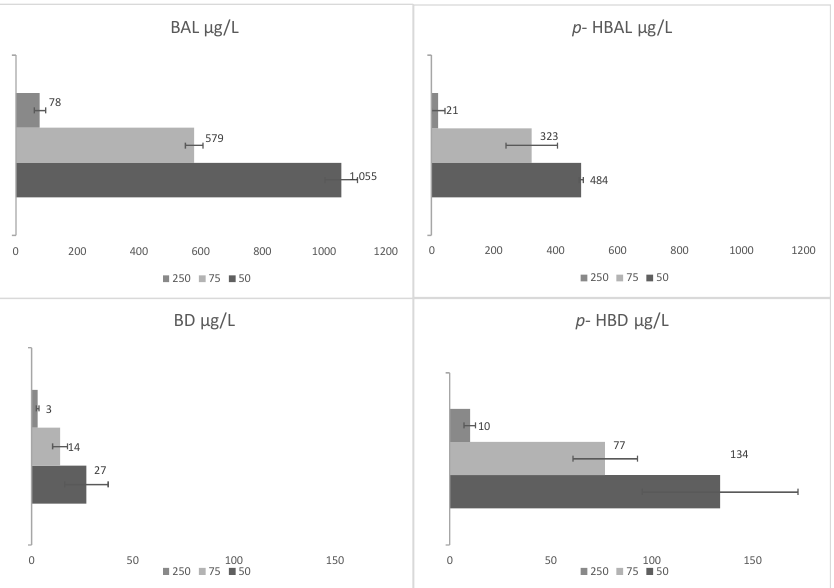
Figure 5. Formation of benzyl alcohol (BAL), benzaldehyde (BD), p -hydroxybenzyl alcohol ( p -HBAL), and p -hydroxybenzaldehyde ( p -HBD) by Hanseniaspora vineae 12/196 in the chemically-defined grape medium with three yeast assimilable nitrogen levels, where nitrogen levels of 75 and 250 mg/L were reached via the addition of diammonium phosphate. Fermentations were conducted at 20 °C; data are expressed in micrograms per liter.